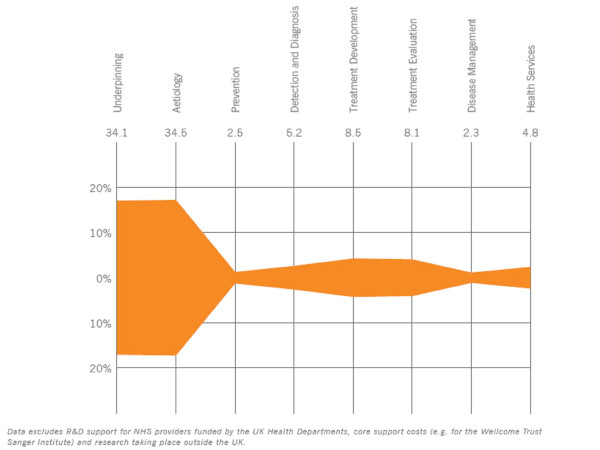
Proportion of combined research activity, Kite diagram*. *Source: UK Clinical Research Collaboration. UK Health Research Analysis. 2006 Available from: